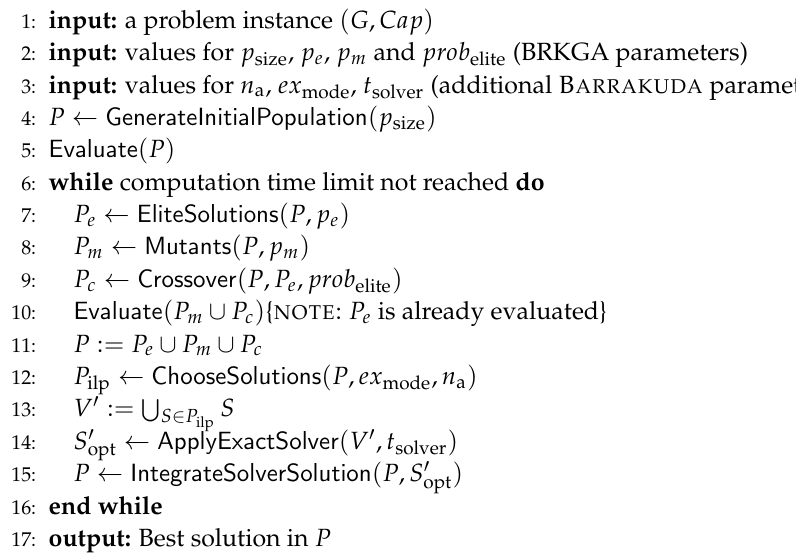
Algorithm 3 B ARRAKUDA for the CapMDS